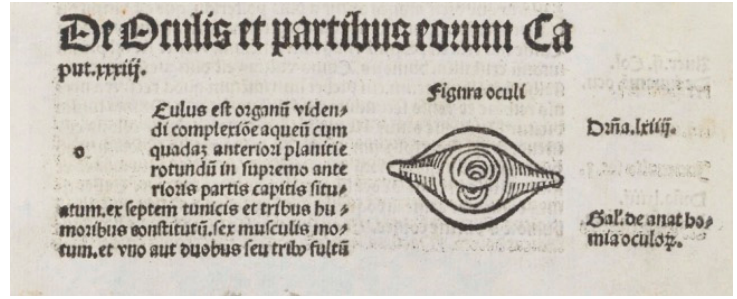
Figure 3. Hundt’s illustration of an eye, beginning of chapter 33 (Hundt 1501, fol. H IV r ).